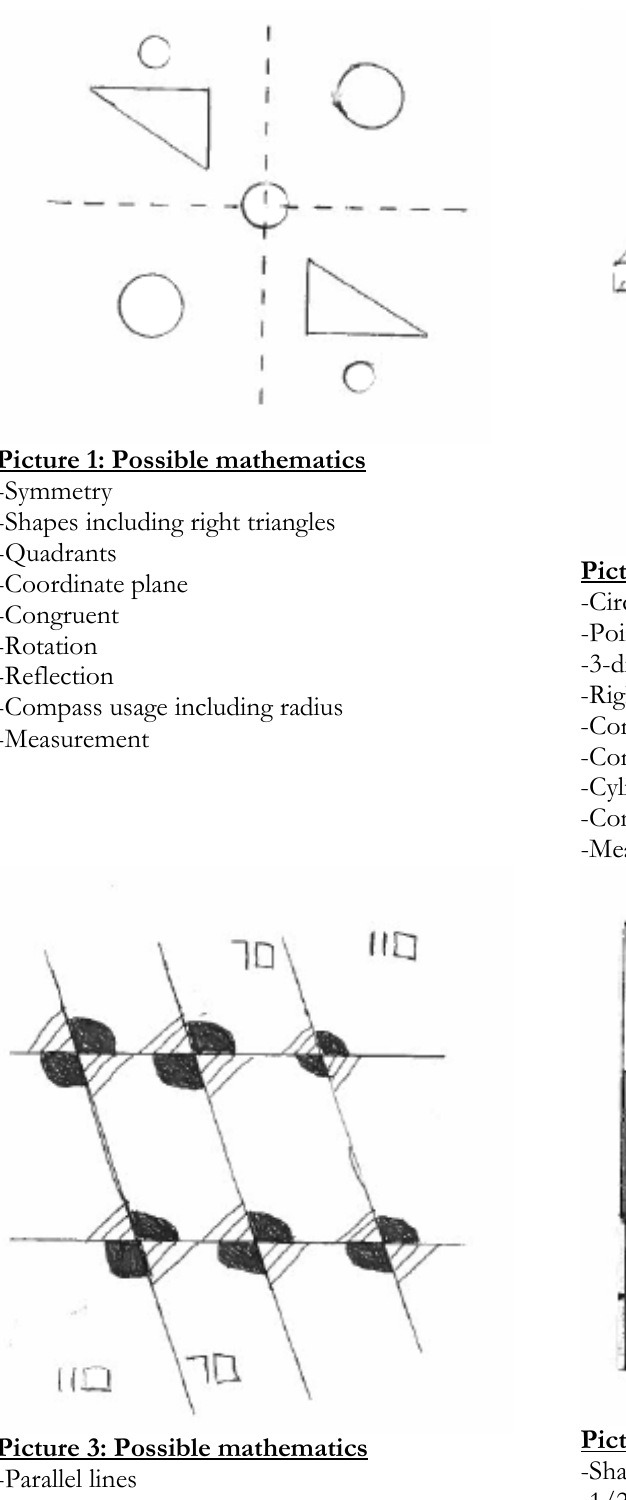
Figure 1. Sample pictures along with possible mathematics students could